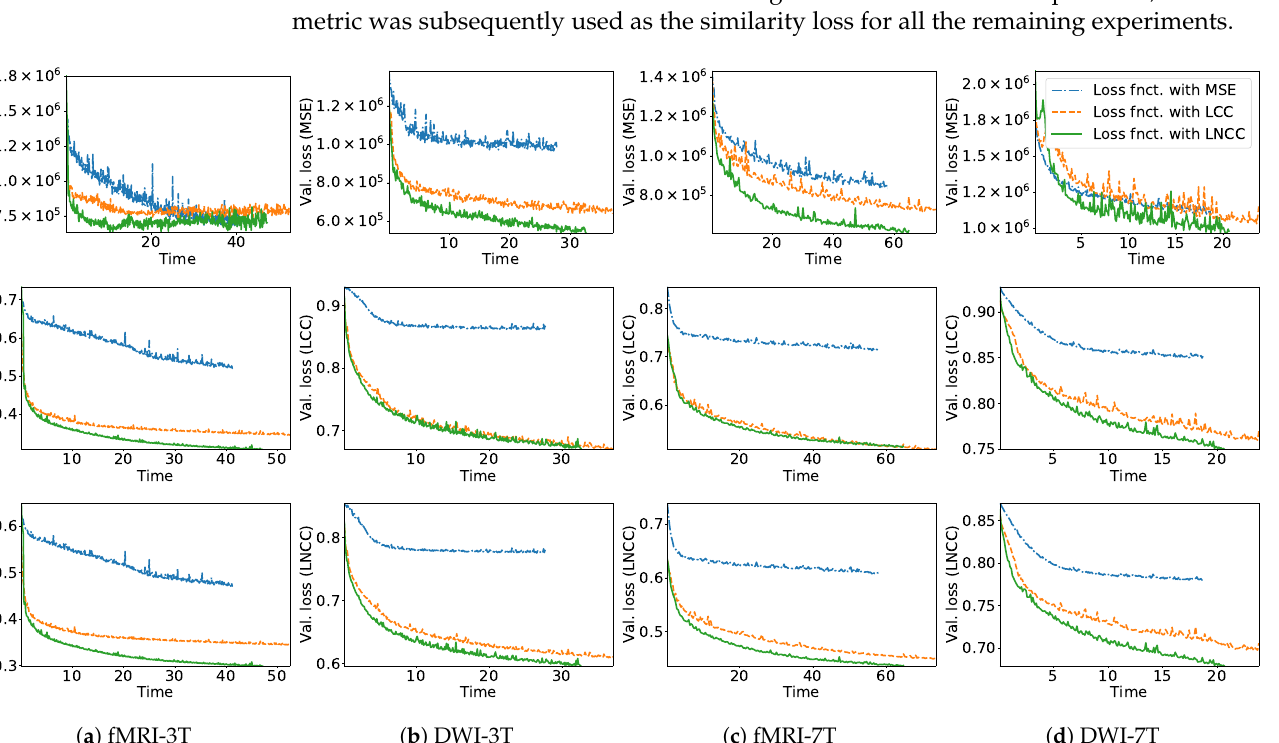
Figure 3. Validation loss of the models trained with three types of similarity loss (MSE, LCC, and LNCC) versus training time (in hours) on the four datasets: ( a ) fMRI-3T; ( b ) DWI-3T; ( c ) fMRI-7T; ( d ) DWI-7T. Top row : validation loss in terms of MSE. Middle row : validation loss in terms of LCC. Bottom row : validation loss in terms of